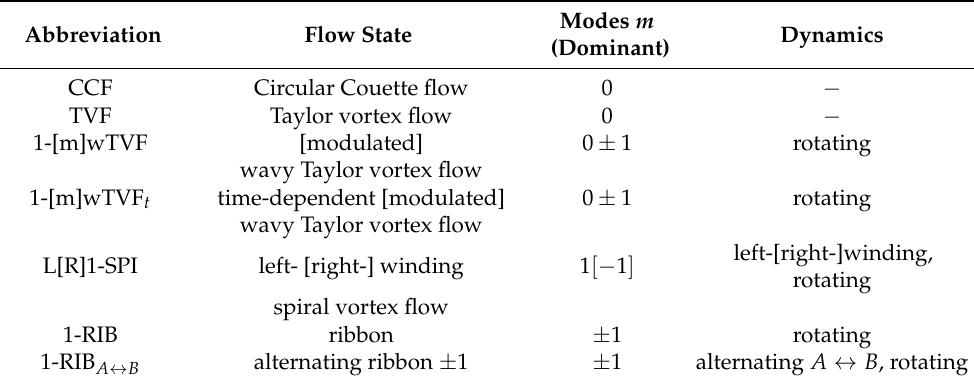
Table 1. Flow state nomenclature and abbreviations. From left to right: Abbreviation, flow state, dominant Fourier modes, and